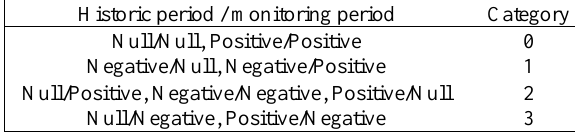
Table 1. Categorization based on slopes of linear trends